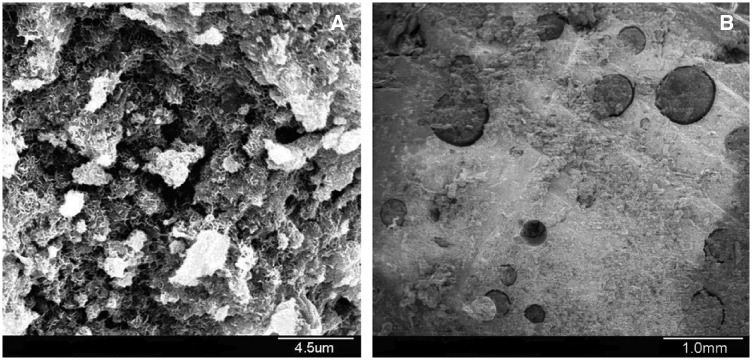
SEM micrographs of the surface morphology of β-TCP/CPC (A) and chitosan microsphere/CPC scaffolds (B)